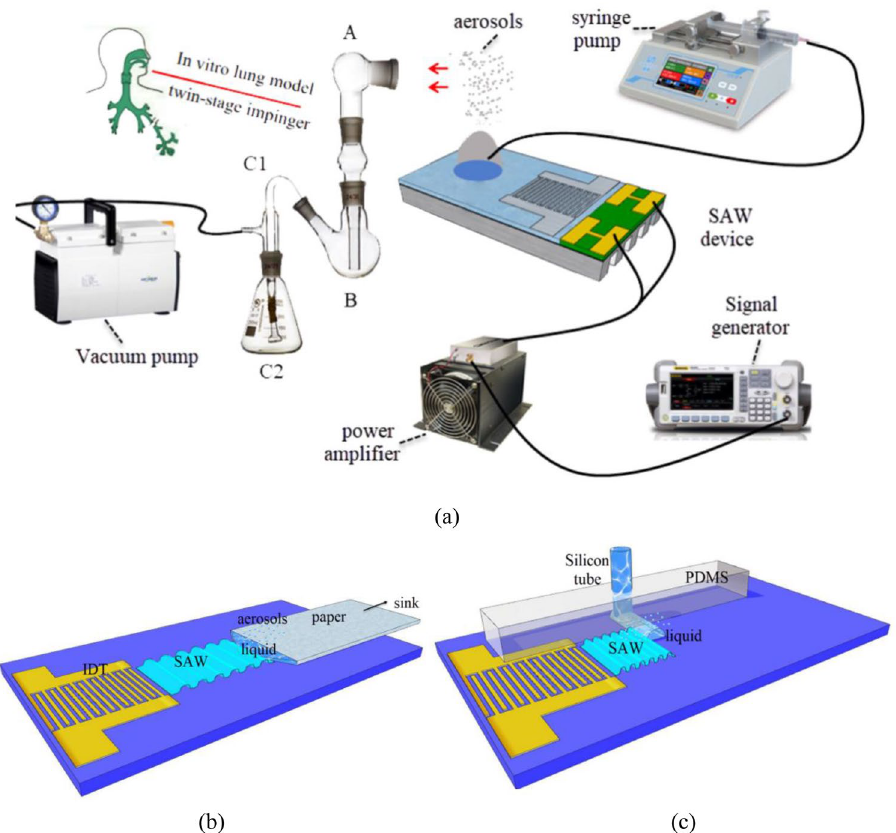
Figure 3. Schematic diagram of the glass twin-stage impinger lung model employed for the dose measurements. ( a ) schematic diagram of experimental device. ( b ) continuous atomization based on paper. ( c ) continuous atomization based on